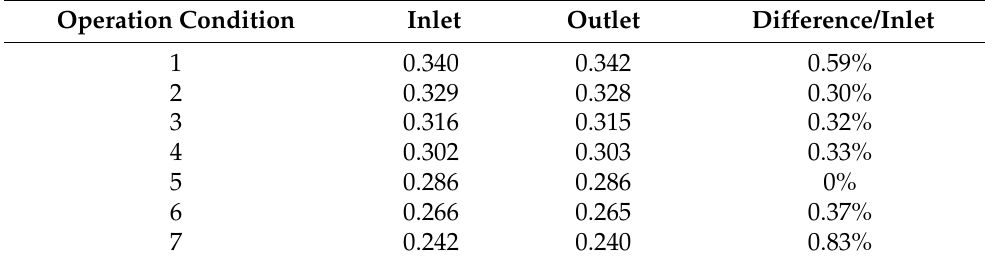
Table 3. Mass flow rates on the inlet and the outlets at different operation conditions obtained by the IB-5 grid.